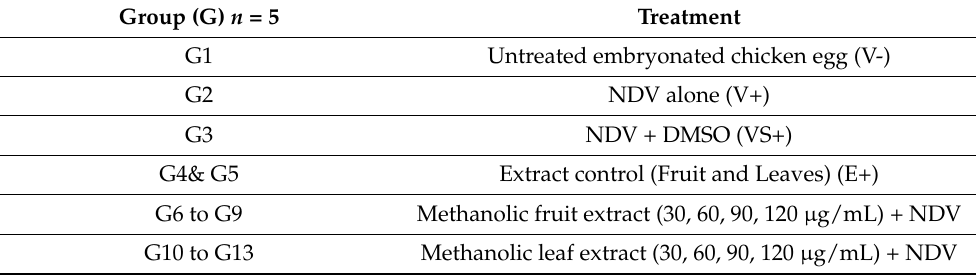
Table 8. Grouping and treatment allocation for the in ovo